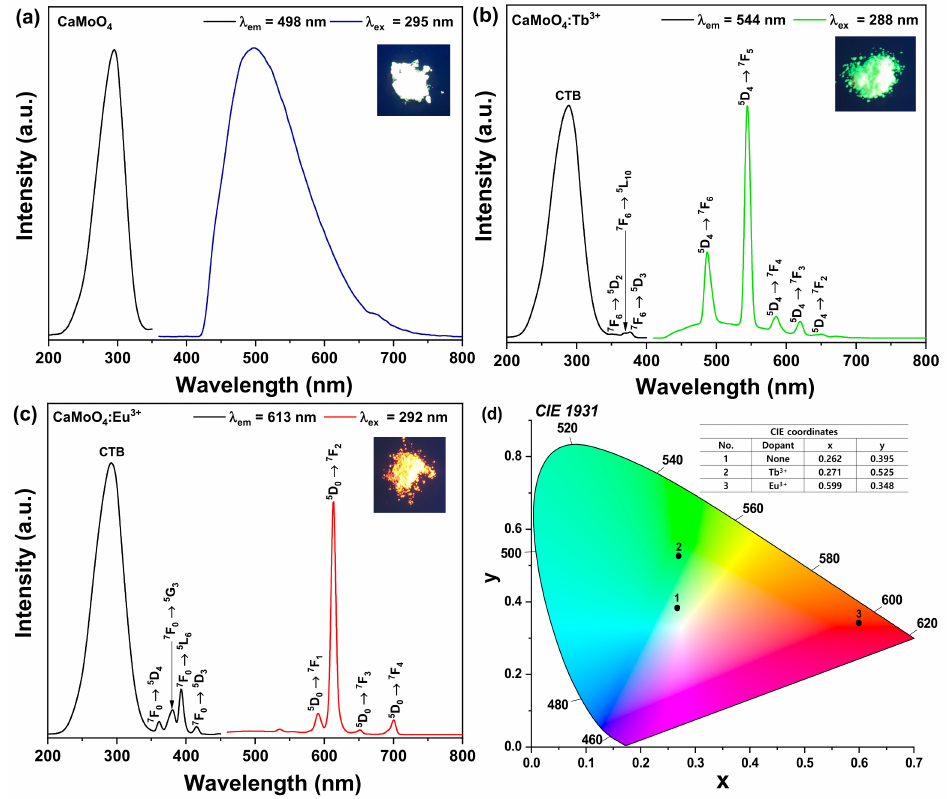
Figure 5. PLE and PL spectra of ( a ) CaMoO4, ( b ) CaMoO4:Tb3+, ( c ) CaMoO4:Eu3+, and ( d ) CIE coordination.